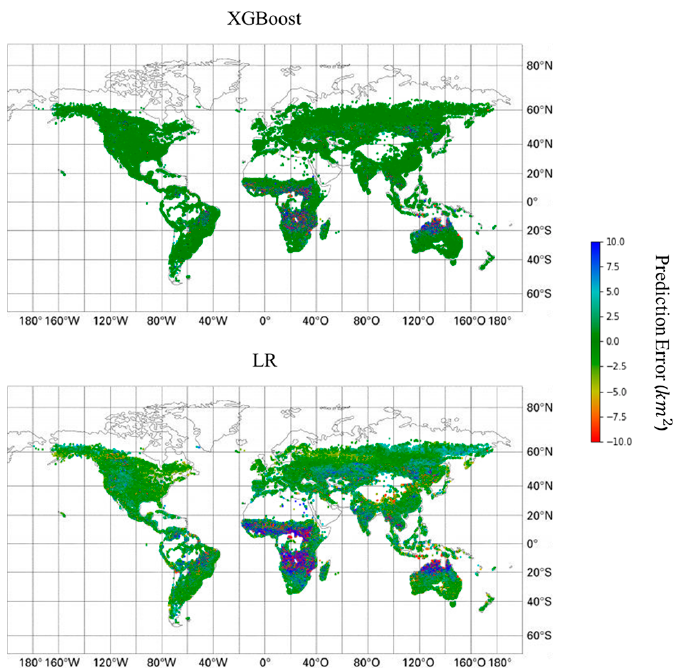
Figure 7. Prediction accuracy map—size of burned areas. The map presents the mean MAE score